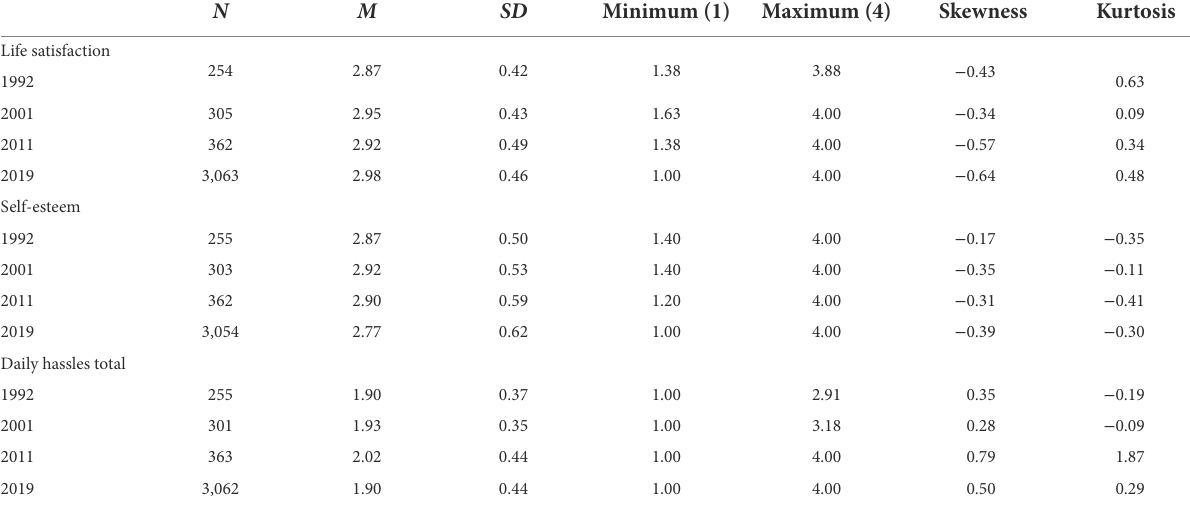
TABLE 2 Descriptive statistics of individual daily hassles domains by